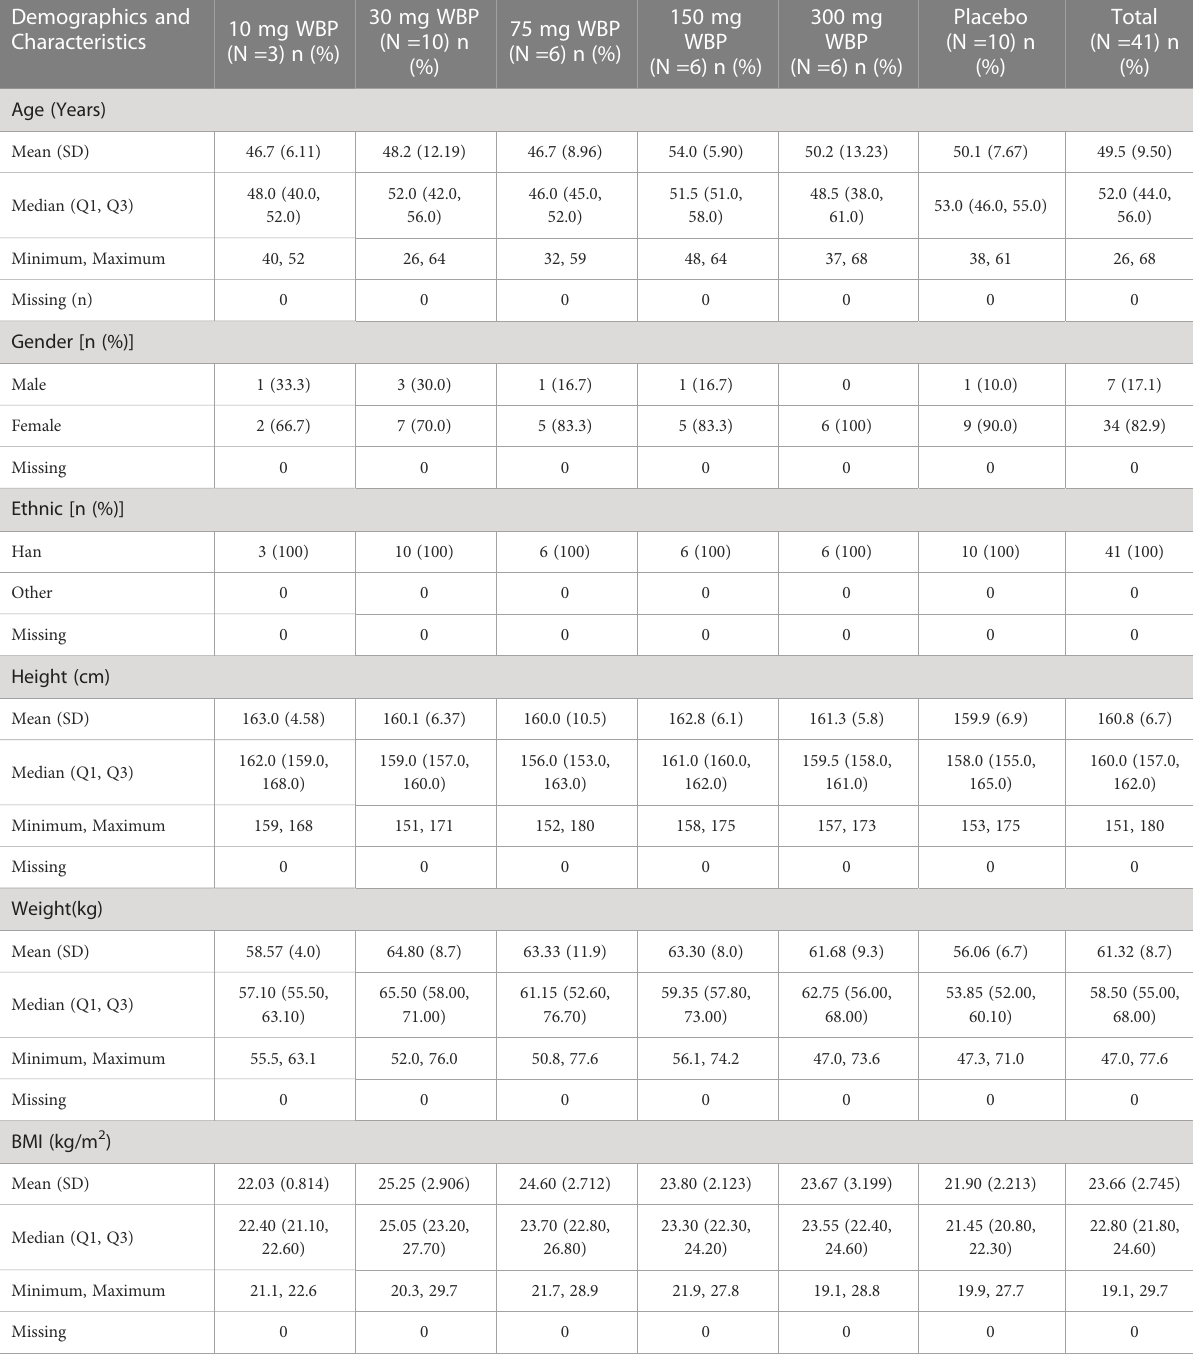
TABLE 1 Demographics and clinical characteristics: Full analysis